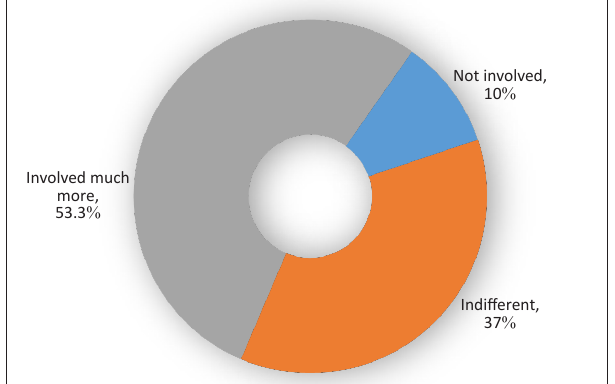
FIGURE 9: Private sector